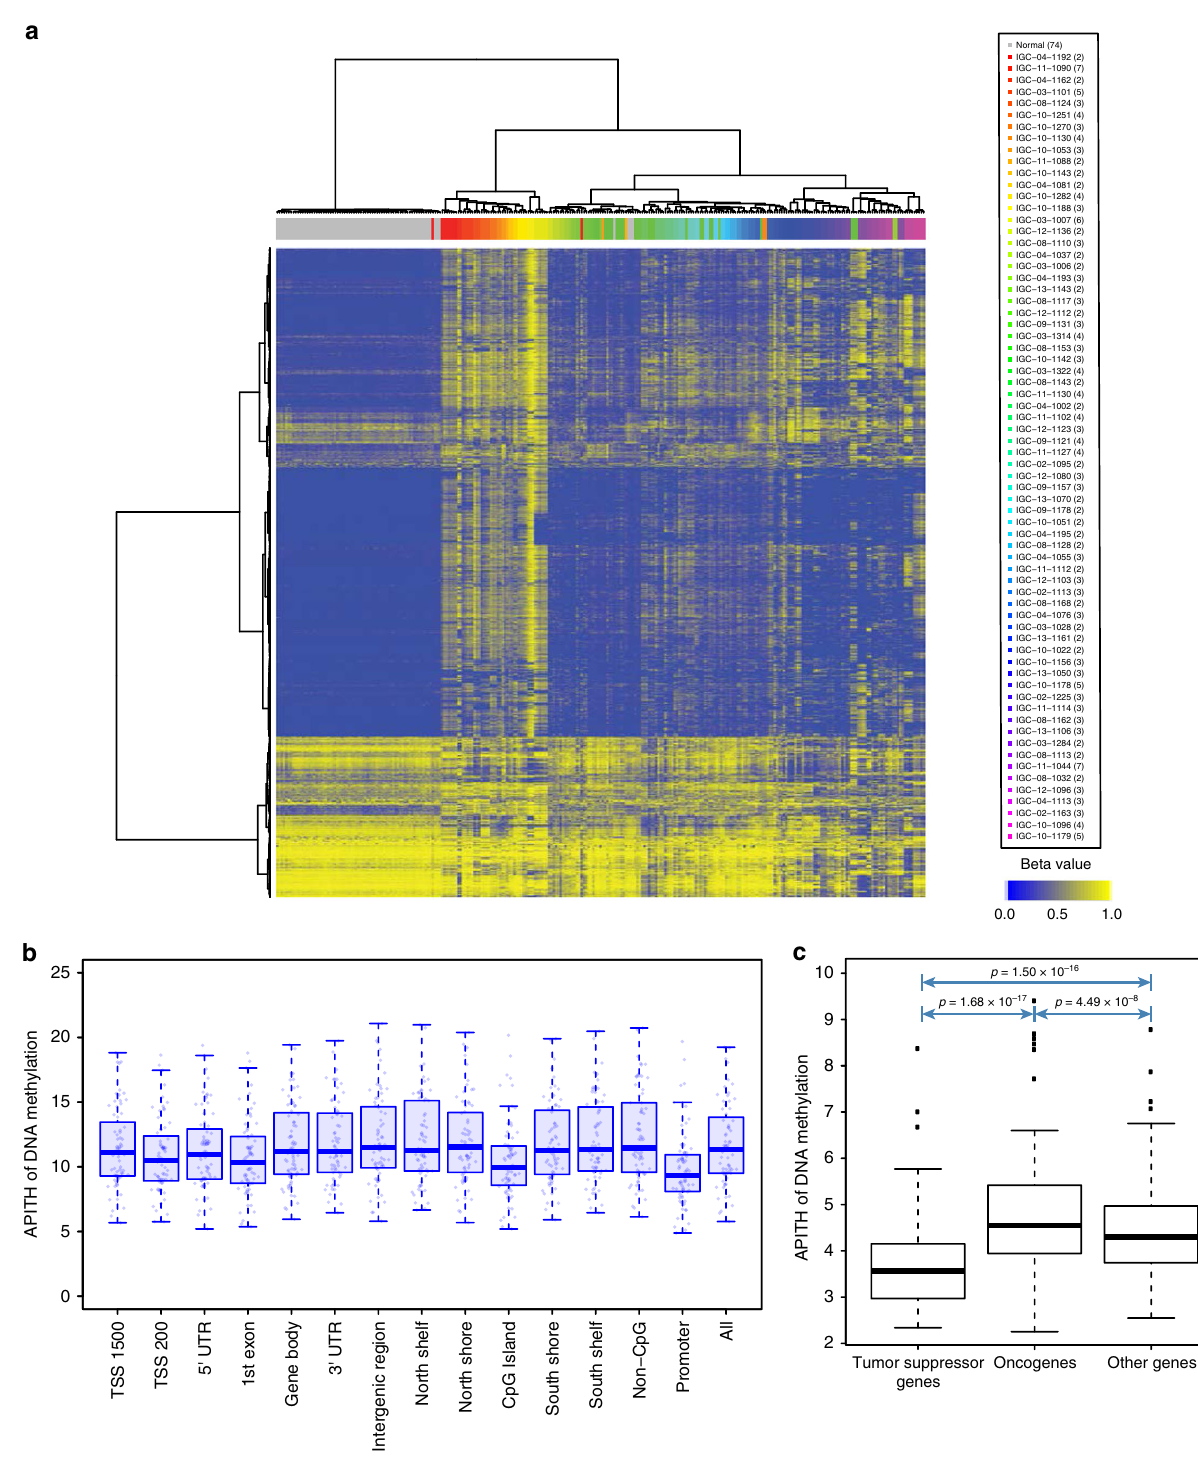
Fig. 4 Intratumoral heterogeneity of DNA methylation pro fi les. a Unsupervised hierarchical clustering of 5000 most variable probes in CpG islands of the genome in 68 subjects. Different tumors are indicated by different colors in the column sidebar, with normal samples colored in gray. The numbers in parenthesis are the number of normal tissue samples for the ‘ normal ’ group, or the number of tumor samples in each patient. The beta values represent estimates of methylation levels, with 0 being unmethylated and 1 fully methylated. b Distribution of ITH of DNA methylation in different genomic contexts. TSS 1500: 200 – 1500 bases upstream of the transcription start sites (TSS), TSS 200: 0 – 200 bases upstream of the TSS. 5 ′ UTR: Within the 5 ′ untranslated region, between the TSS and the ATG start site. Gene body: Between the ATG and stop codon. 3 ′ UTR: From the stop codon to poly A tail. Island: CpG island. Shore: 0 – 2 kb from island. Shelf: 2 – 4 kb from island. North: upstream (5 ′ ) of island. South: downstream (3 ′ ) of island. c ITH of DNA methylation in oncogenes ( n = 176), tumor suppressor genes ( n = 223) and other genes ( n = 12,837). The p -values are based on unpaired two-sided t -test of the two groups indicated by arrows. The center line in the box plots indicates median APITH. The box length indicates the interquartile range (IQR). The whiskers extend to the largest and smallest APITH at most